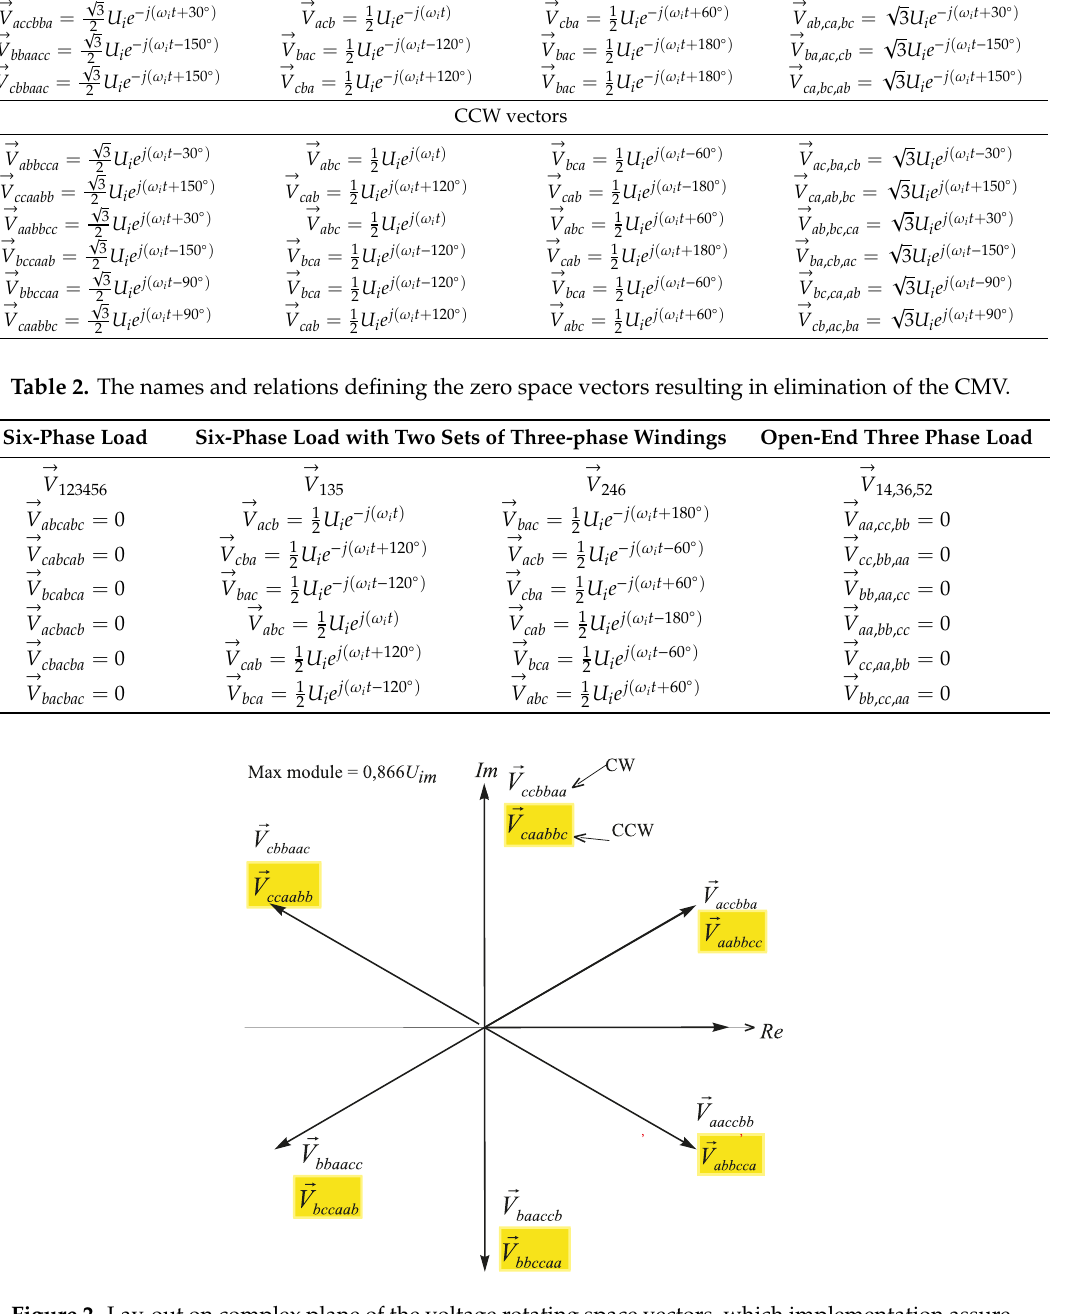
Figure 2. Lay-out on complex plane of the voltage rotating space vectors, which implementation assure the CMV elimination.